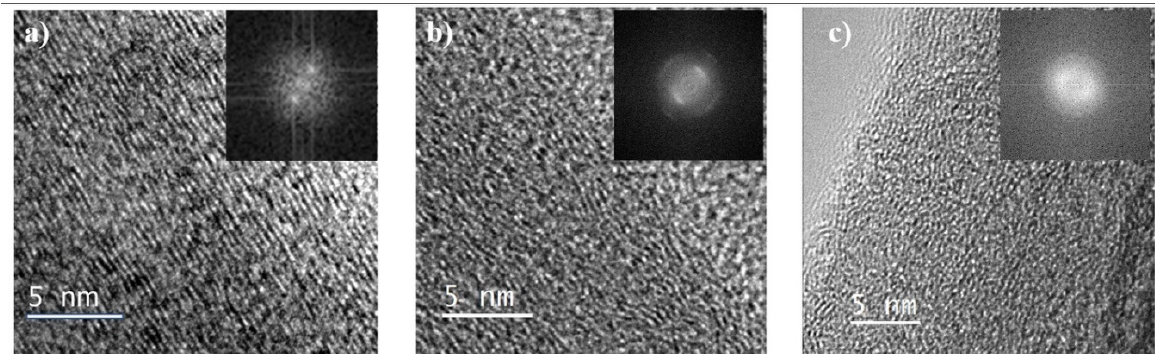
Figure 4. High-resolution TEM images of PAN-based carbons: ( a ) compression-induced CIPC, ( b ) tension-induced TIPC, and ( c ) without mechanical treatment. Micrograph (c) is provided for comparing the microstructure of mechanically activated carbons ( a , b ) with untreated (no mechanical activation) PAN-based pyrolytic carbon ( c ). The inset in the upper right corner of each micrograph displays the Fast Fourier Transform (FFT using a Gatan Digital micrograph) of the microstructure of each PAN-based carbon.